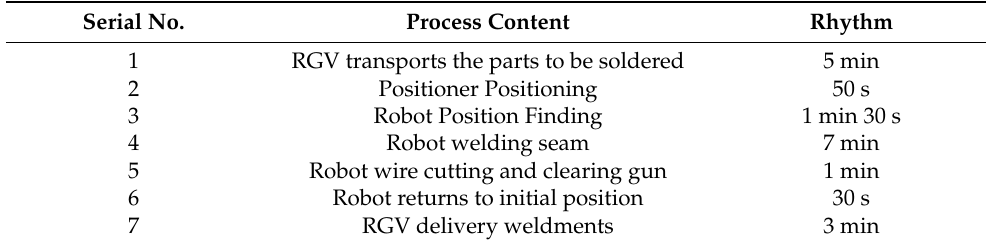
Table 1. Workpiece welding process. Serial No. Process Content Rhythm 1 RGV transports the parts to be